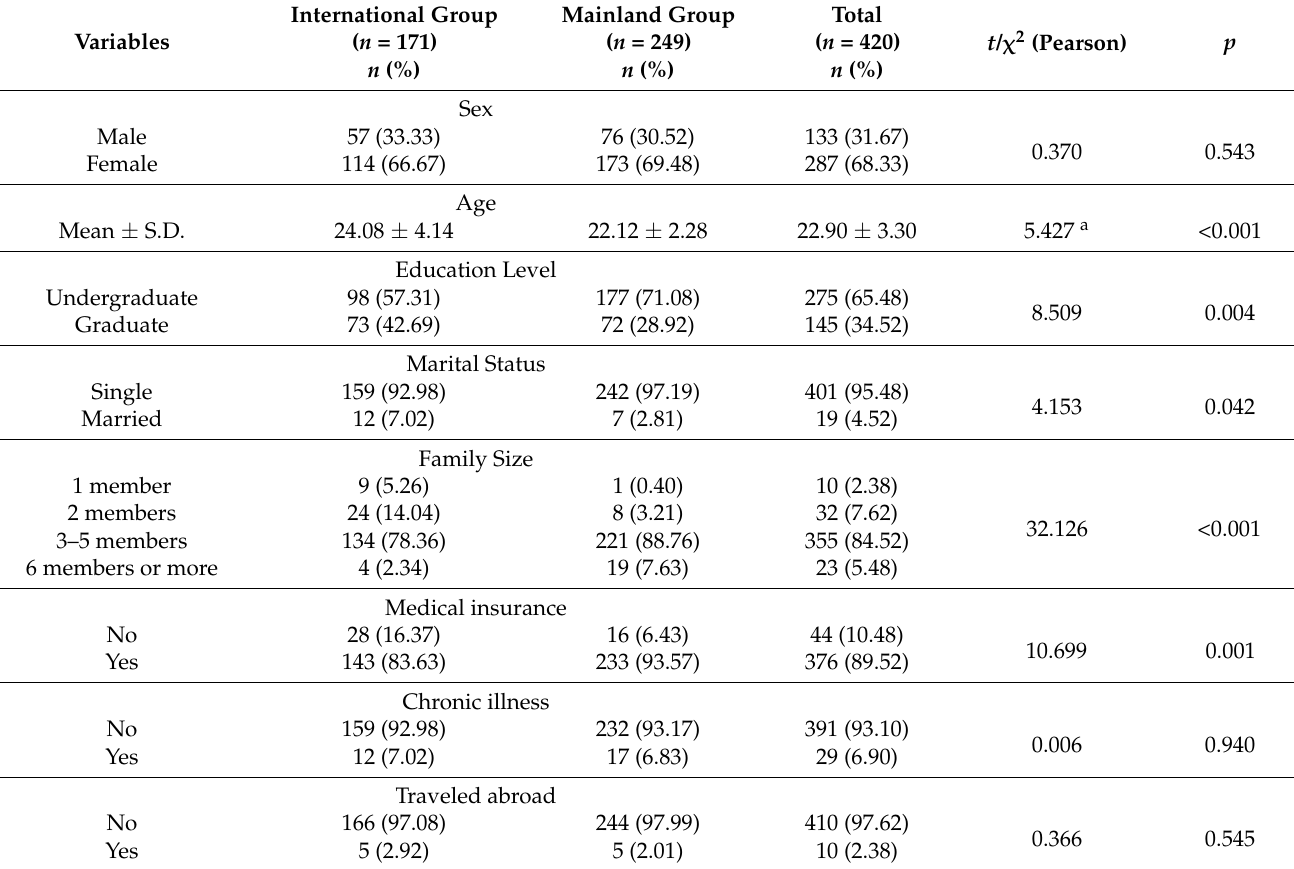
Table 1. Demographics and general characteristics of the